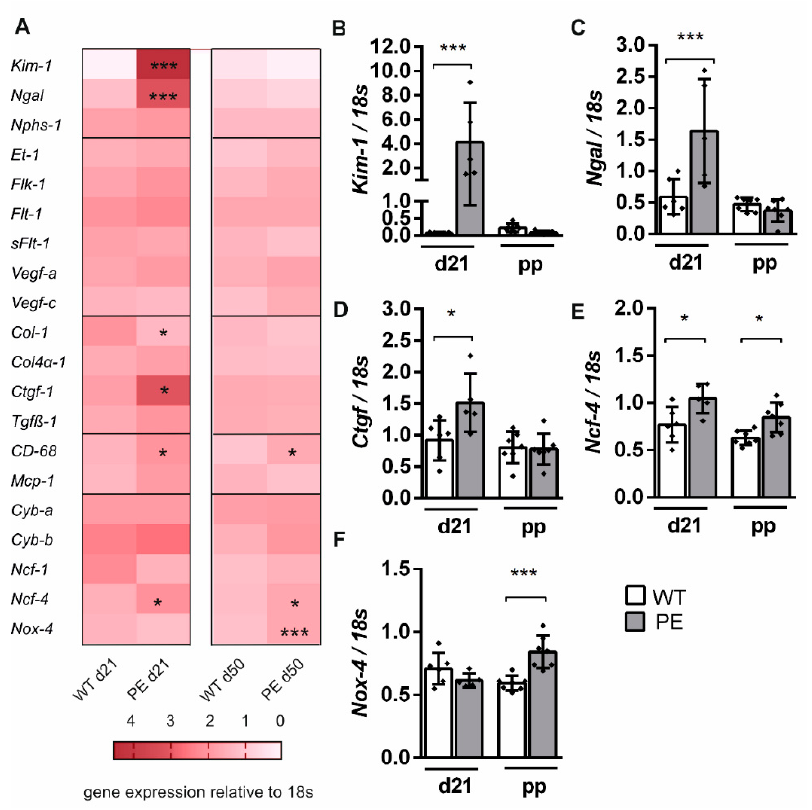
Figure 2. Renal injury marker expression was altered during and slightly after preeclamptic pregnancy. ( A ) Descriptive overview of hypothesis-driven relative gene expression in kidney tissue during preeclamptic (PE) and control (WT) pregnancy (day 21) and postpartum (day 50). Analyzed genes are marker for nephron injury, angiogenesis, inflammation, fibrosis, and oxidative stress (from top to bottom). Legend indicates means of relative gene expression normalized to 18S expression. ( B – F ) Marker genes that show altered expression in the PE group are emphasized. ( B , C ) Nephron injury marker kidney injury molecule-1 ( Kim-1 ) and neutrophil gelatinase-associated lipocalin 2 ( Ngal ) were elevated during preeclamptic pregnancy compared to WT. ( D ) Fibrosis marker connective tissue growth factor ( Ctgf ) expression was slightly increased during preeclamptic pregnancy. ( E , F ) Oxidative stress marker expression of neutrophil cytosolic factor 4 ( Ncf-4 ) and NADPH oxidase 4 ( Nox-4 ) was higher during and/or after preeclamptic pregnancy. All genes are normalized to 18s expression. Statistical analysis was performed using a two-way ANOVA. Bars are indicated as mean ± SD ( n = 5–7). p -value is shown in comparison to respective controls as * p ≤ 0.05; *** p ≤ 0.001.